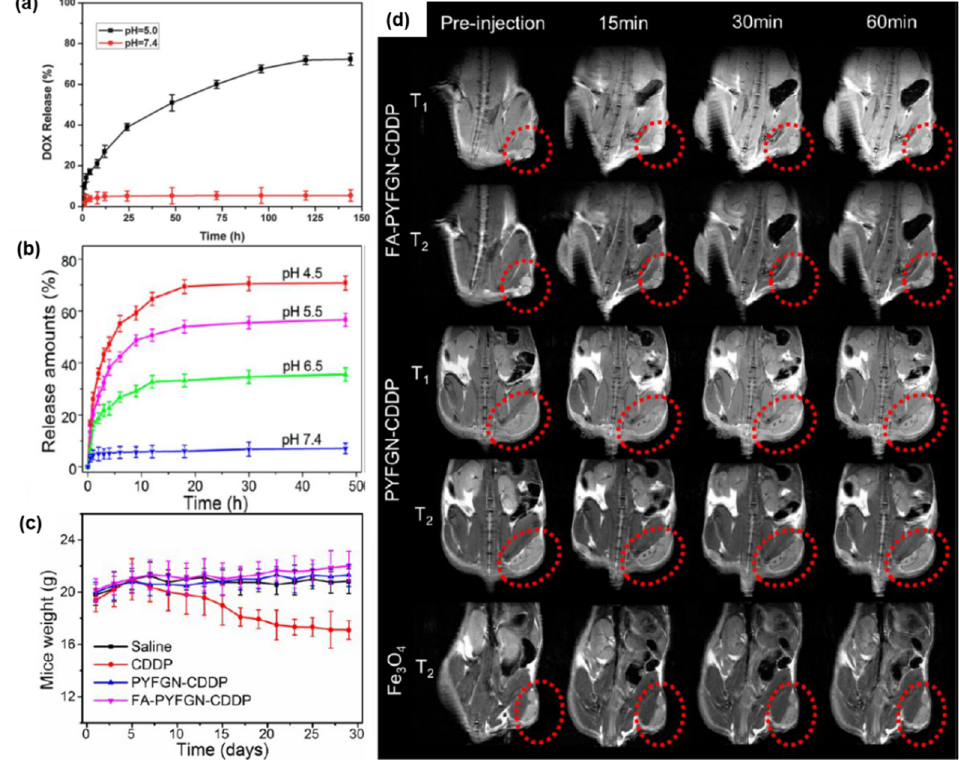
Figure 33. ( a ) Release of DOX in vitro from drug-loaded pH-responsive PEG-PBLA-coated hollow SiO 2 NPs with SPIONs at different pH values at 37 °C. Reproduced with permission from reference [146]. Copyright 2012 Royal Society of Chemistry. ( b ) Cisplatin release from Fe 3 O 4 @Gd 2 O 3 yolk-shell NPs functionalized with PEG and FA (FA-PYFGN-CDDP) under different pH conditions. ( c ) Body weight changes after tumor-bearing nude mice were treated with free cisplatin (CDDP) and cisplatin-loaded Fe 3 O 4 @Gd 2 O 3 yolk-shell NPs functionalized with PEG (PYFGN-CDDP) or FA (FA-PYFGN-CDDP) via tail vein injection. ( d ) Gd 2 O 3 -weighted (T1) and Fe 3 O 4 -weighted (T2) MR images of mouse tumors acquired preinjection and postinjection of FA-PYFGN-CDDP and PYFGN-CDDP. Tumors are marked by red dashed circles. Reproduced with permission from reference [122]. Copyright 2017 American Chemical Society.